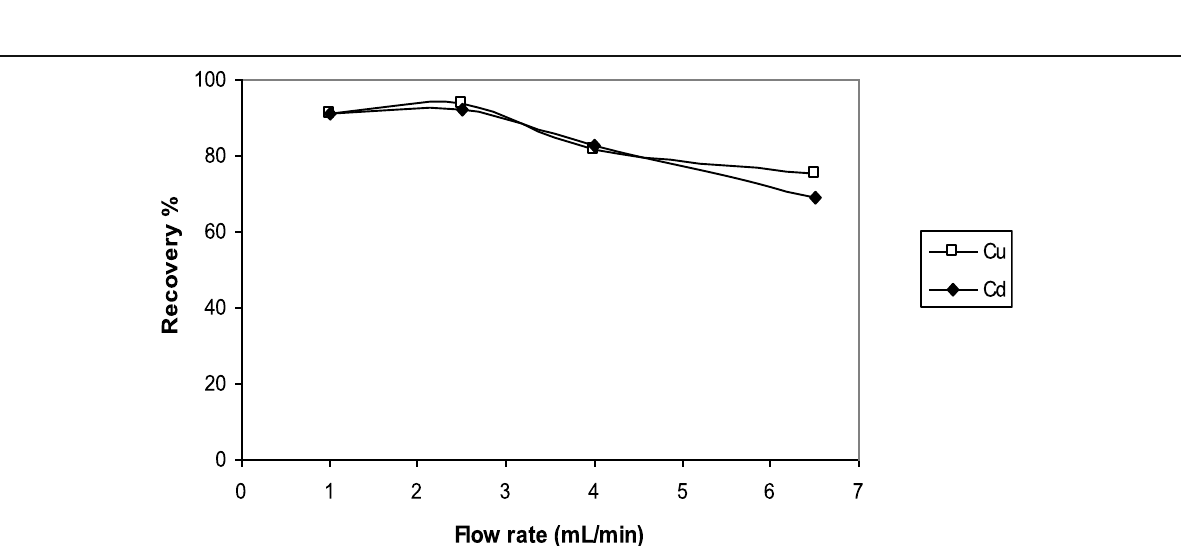
Fig. 3 Effect of flow rate on the recovery of Cu(II) and Cd(II) by Phanerochaete chrysosporium immobilized on